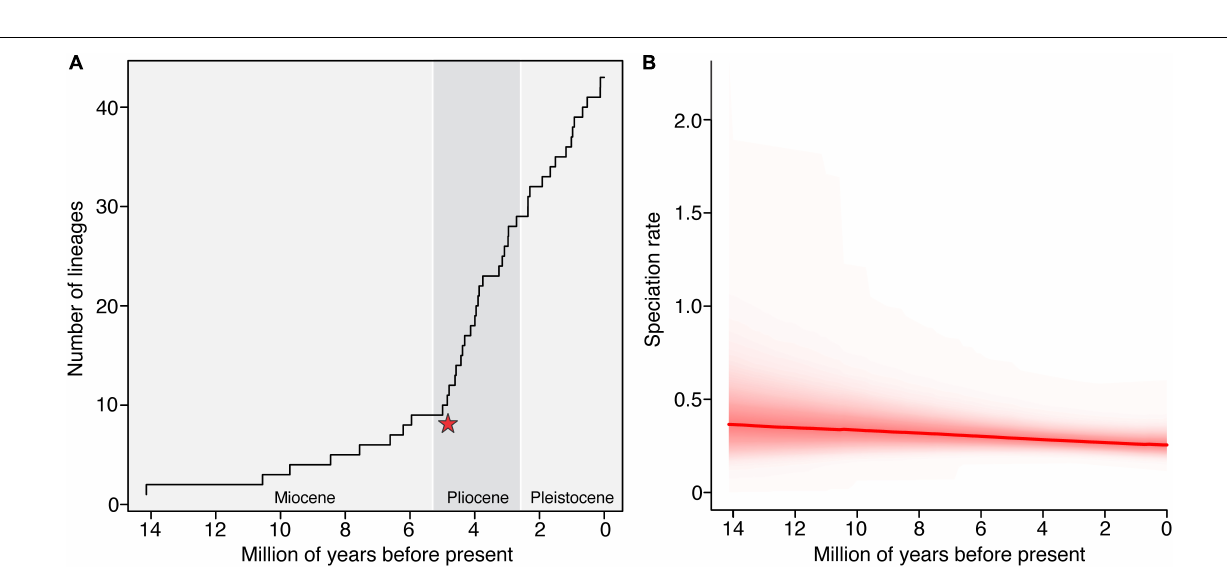
FIGURE 3 | Speciation plots of Sciurini. (A) Lineage-through-time (LTT) plot showing a rapid increase in lineage accumulation after the South American invasion (red star). (B) BAMM analysis demonstrating the mostly constant speciation rate of Sciurini through time; solid red line shows median estimate and thin red lines (cloud) indicate probability